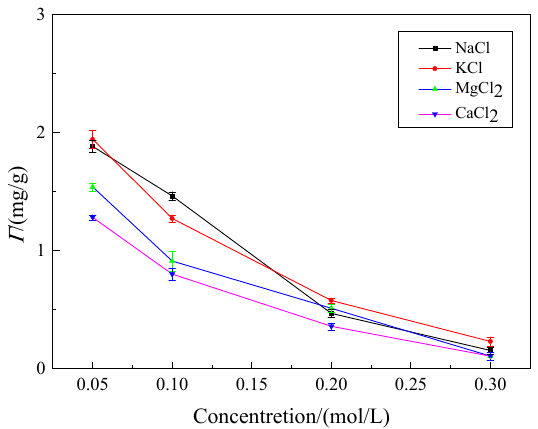
Figure 13. Effect of inorganic salt on welan gum adsorption on montmorillonite.